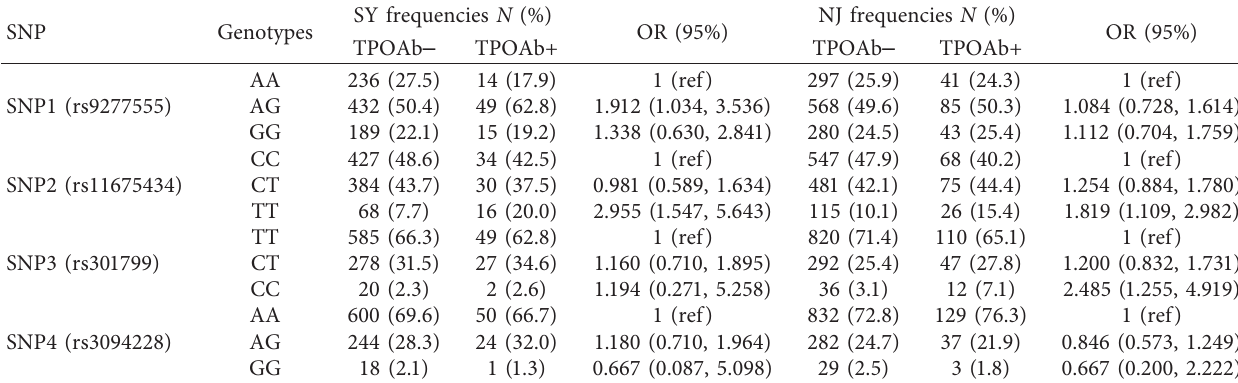
Table 4: Genetic risk estimation for 4 SNPs and TPOAb.